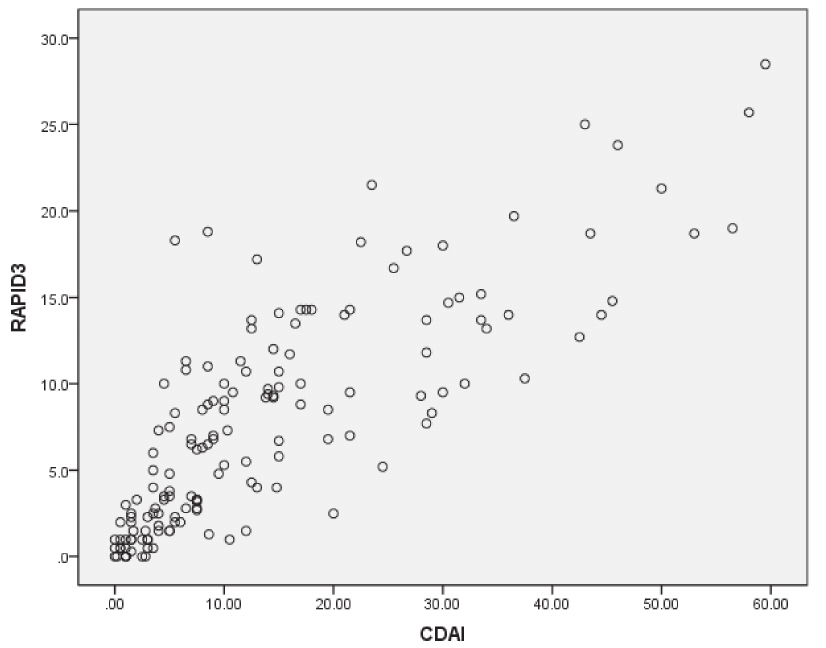
Figure 2. Scatter plots of correlation between RAPID3 and CDAI in 156 patients with Rheumatoid Arthritis (spearman’s method).